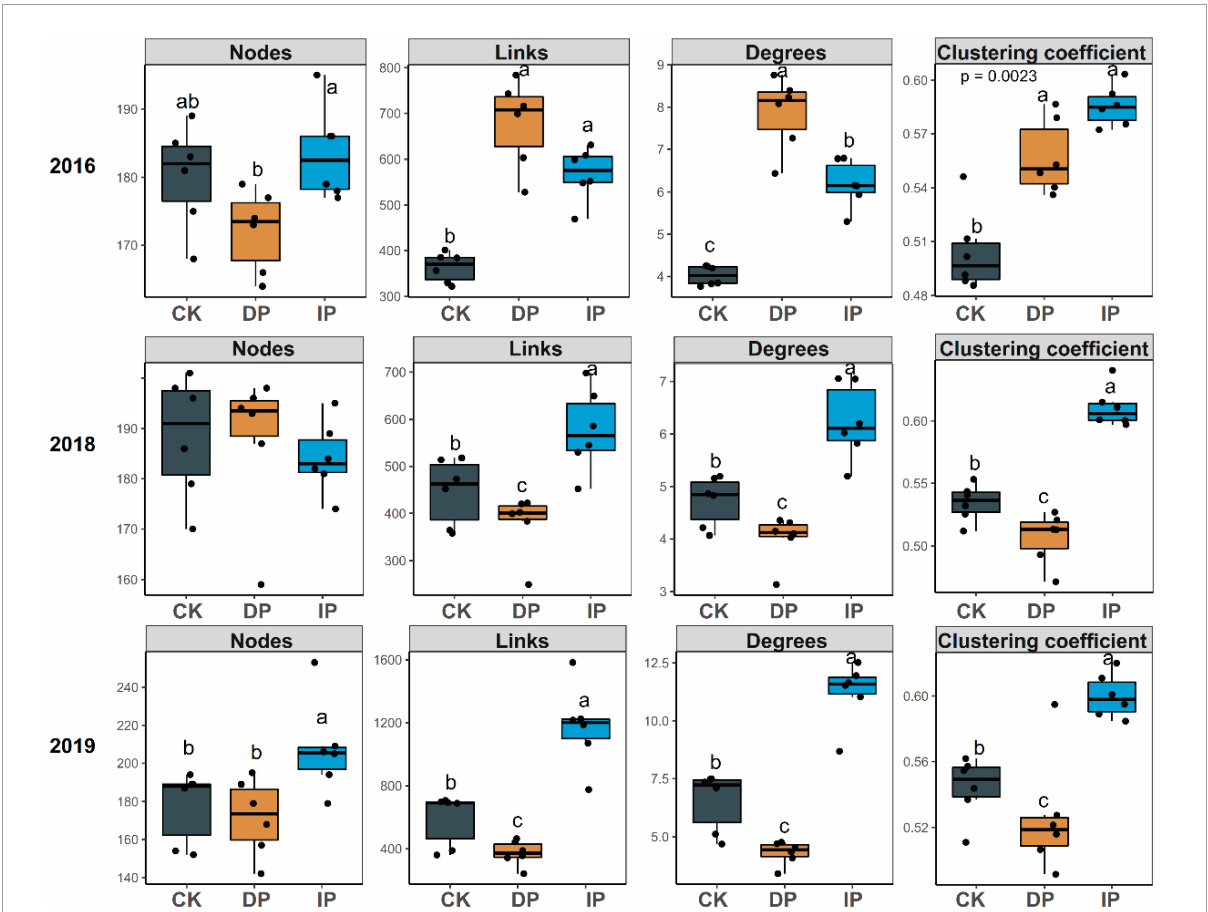
FIGURE2 Topological properties of the bacterial co-occurrence networks in different precipitation gradients in 2016, 2018, and 2019. CK, control; DP, decreased precipitation; IP, increased precipitation. Different lowercase letters indicate significant differences among the three sites ( P < 0.05).